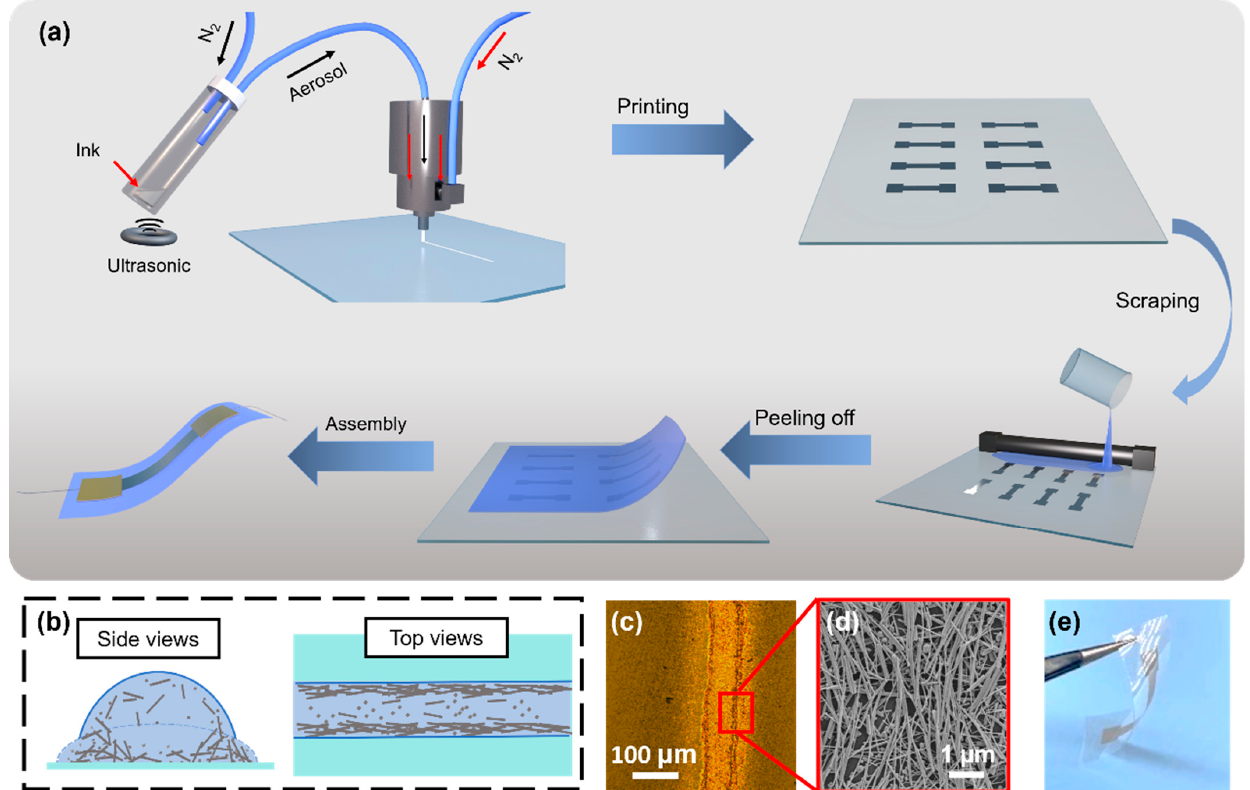
Figure 1. Fabrication of structurally integrated 3D conductive networks of hybrid AgNRs/NPs. ( a ) Schematic of fabrication procedure for 3D conductive networks of hybrid AgNRs/NPs embedded in a polymer matrix. ( b ) The dewetting model of deposited quasi-parallel droplets showing Ag species migrating outward and assembling orientedly. ( c ) Optical image of the printing pattern showing coffee-ring effect. ( d ) SEM image of oriented assembly of Ag species at the pattern edge. ( e ) Photograph of the elastomer-encased 3D networks.